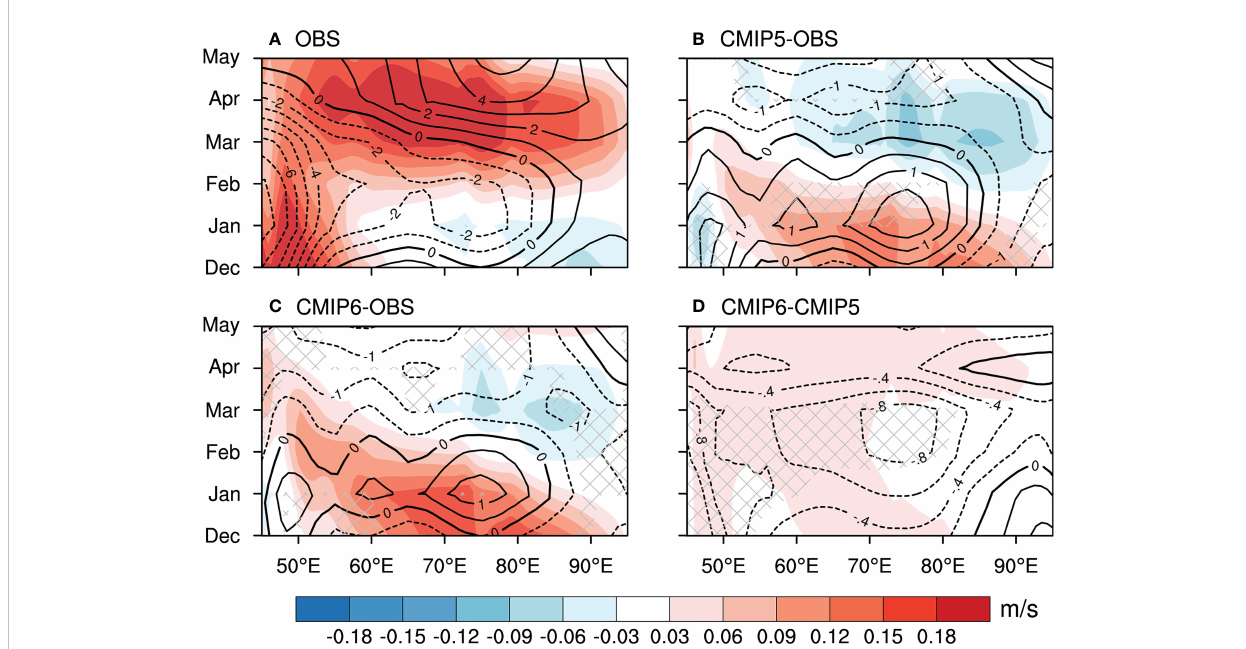
FIGURE 5 (A) Time – longitude cross-section of the climatological zonal wind at 925-hPa (contours; units: m/s) and subsurface (averaged from 60 to 150 m) zonal current (shading; units: m/s) over the EIO (averaged between 2° S and 2° N) from the previous December to May from the SODA 3.4.2 dataset. The MME biases of the EIO zonal winds and subsurface zonal currents in the (B) CMIP5 and (C) CMIP6 models, the gray crosses denote locations over which >70% of models agree on the same sign of zonal wind bias. (D) Difference in the EIO zonal winds and subsurface zonal currents between the CMIP6 and CMIP5 models; the gray crosses indicate signals that are statistically signi fi cant at the 90% con fi dence